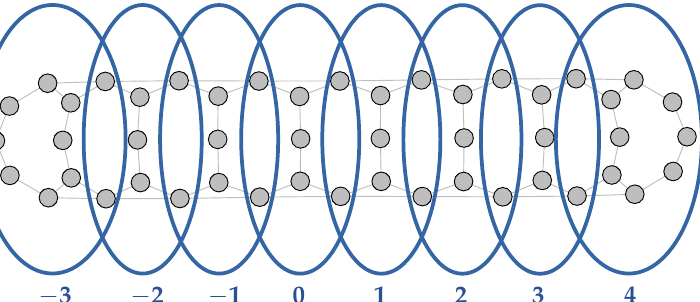
Figure 18. Primal graph and tree decomposition of the transmission line model for N = 5 lump elements, forced in nominal mode. The blue bubbles represent the nodes of the tree decomposition; here, they are indexed from left to right, with node 0 acting as the root of the